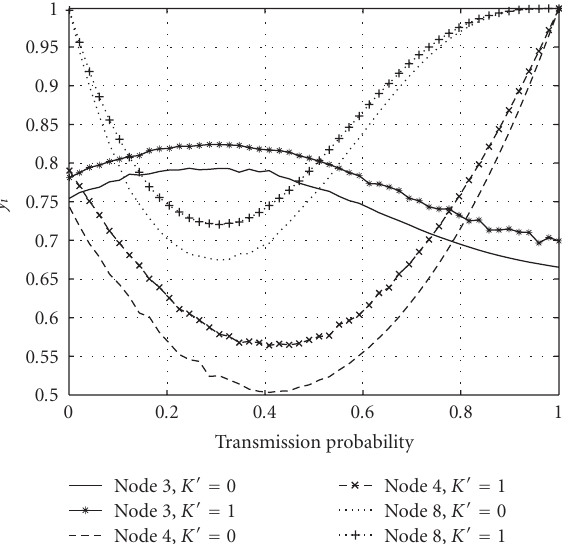
Figure 10: Gain ratio of dynamic case compared to the static one versus K (cid:5) (linear network).